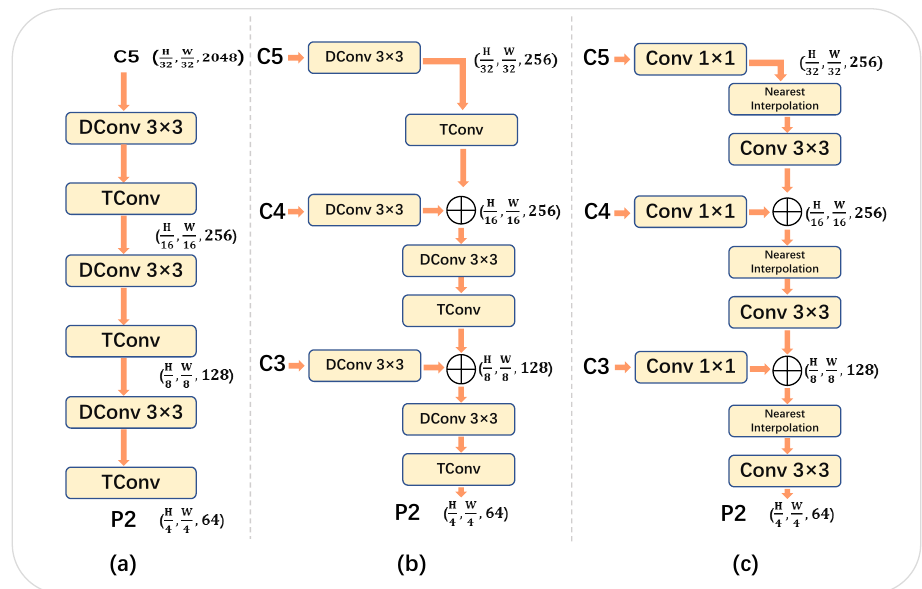
Figure 6. Different kinds of necks to process the backbone features: ( a ) A direct Top-down pathway without the feature pyramid structure; ( b ) our proposed Deformable FPN; and ( c ) standard